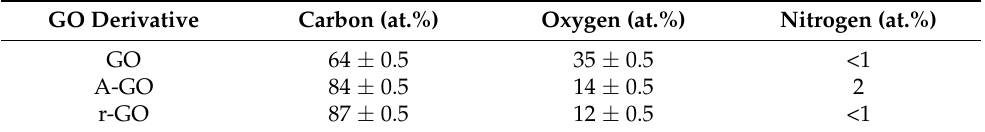
Table 1. Atomic percentages of elements on the graphene oxide derivative surfaces. XPS experiments. GO Derivative Carbon (at.%) Oxygen (at.%) Nitrogen (at.%) GO 64 ± 0.5